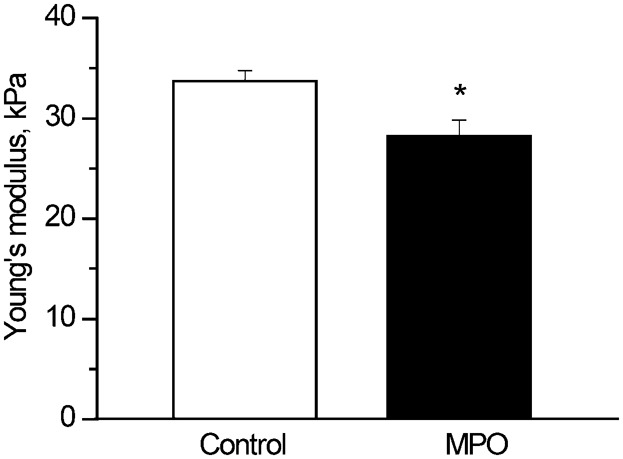
Effect of MPO on surface elasticity of human platelets.Platelets were incubated at 37°C for 10 minutes without (control) or with MPO (100 nM) and then fixed with 1.5% glutaraldehyde for 30 minutes at room temperature before further processing as described in Materials and Methods. Young's modulus of the platelets was measured in the central part of the cell, immediately after the sample preparation. The average values were calculated on the depth of penetration of 25 nm from the force-indentation curves using Hertz's model. Values are mean ± s.e.m. of three independent experiments. *P<0.05, n = 3.